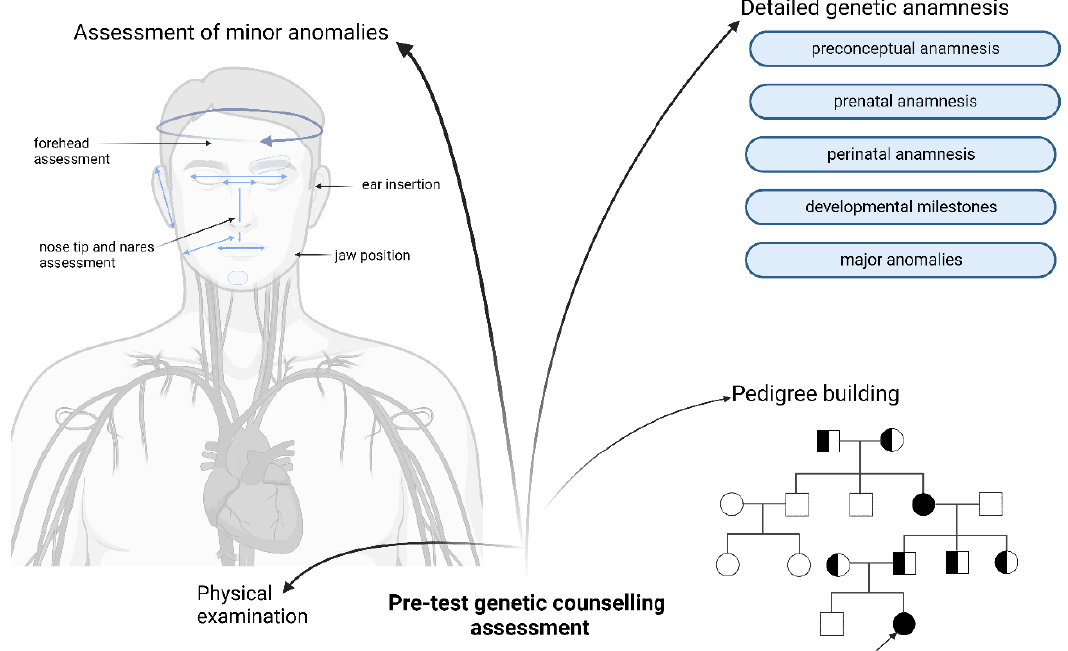
Figure 4. Role of modern genetic counselling—during pre-test counselling, the goal is to elucidate as far as possible the phenotype alterations and to assess the family tree in order to choose the adequate genetic tier test. Created with BioRender.com. (accessed on 8 September 2022).